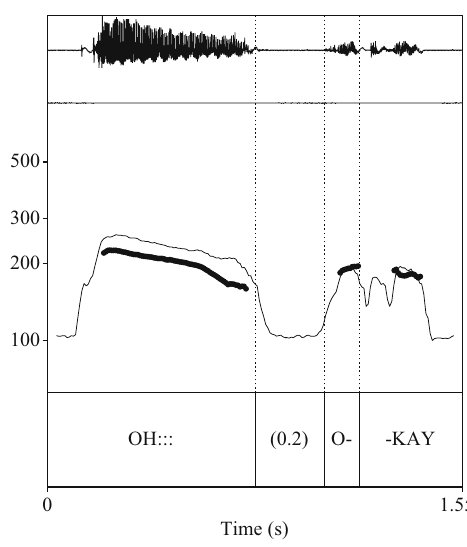
Figure 2: Pitch trace and intensity curve for lines 19 - 20 of Ex. ( 6 ) “ Rummikub ”